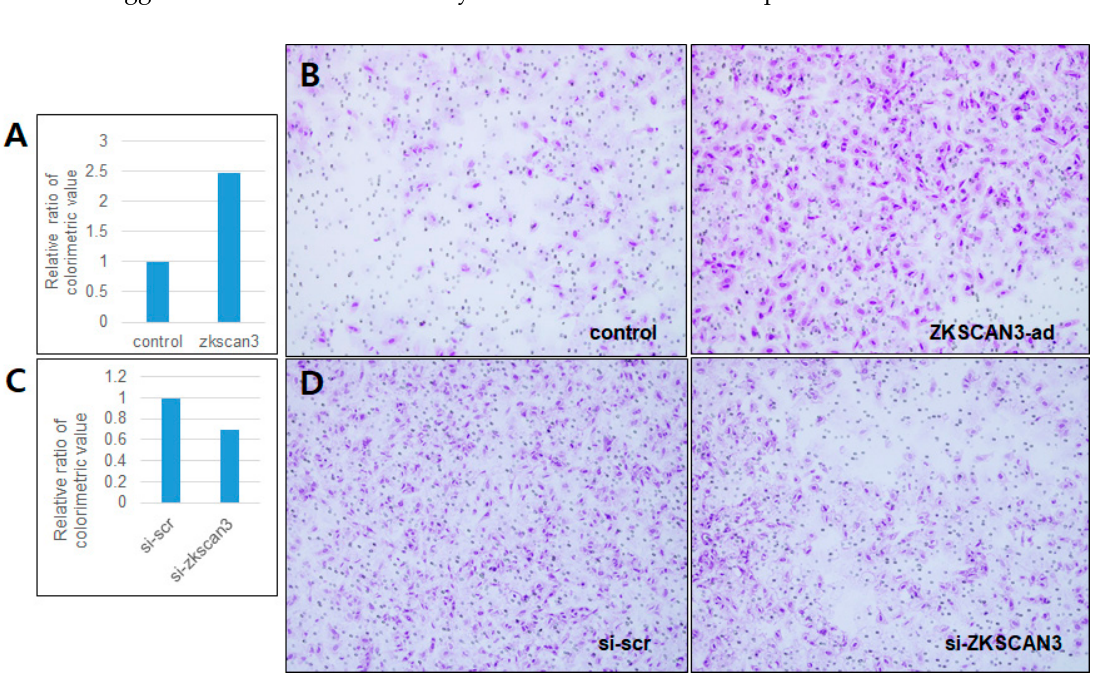
Figure 4. ZKSCAN3 expression affects the invasion ability of HeLa cells. ( A , C ) HeLa cells were transduced with ZKSCAN3-HA adenovirus for 24 h and with siRNA for 48 h, respectively, and then, the transwell invasion assay was performed. ( B , D ) Representative fields of view of each group of cells (hematoxylin stain, 100× magnification).